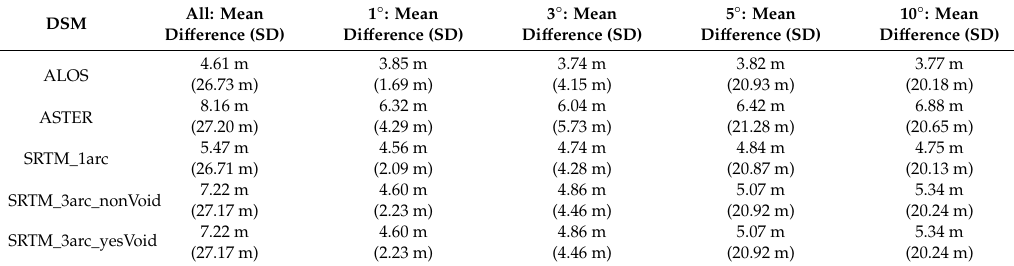
Table 1. Mean absolute di ff erences in elevation between the investigated digital surface models (DSMs) and spatially overlapping Ice, Cloud, and land Elevation Satellite (ICESat) Geoscience Laser